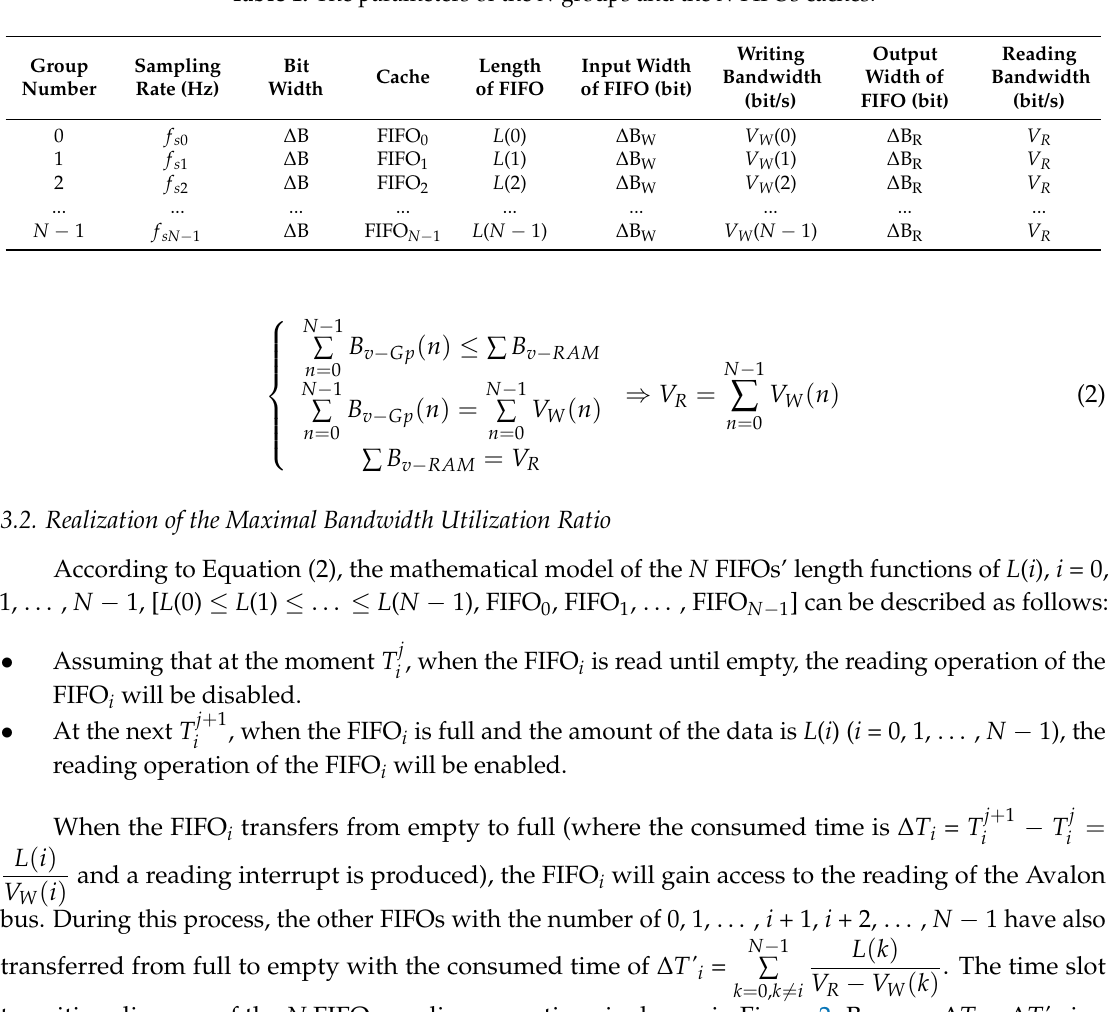
Table 1. The parameters of the N groups and the N FIFOs